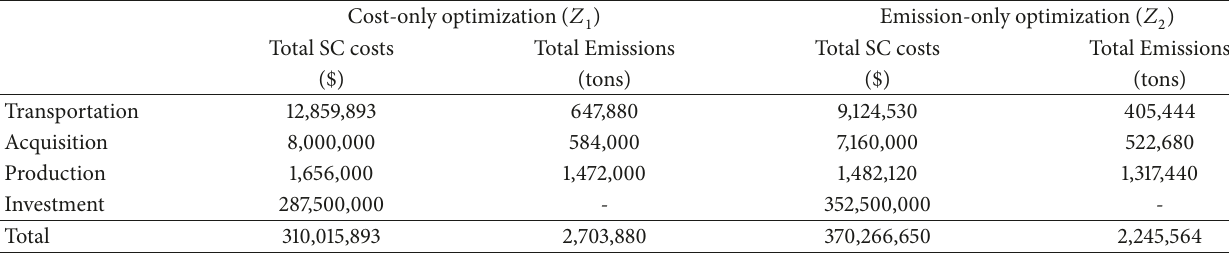
Table 3: Numerical results for the optimizations.